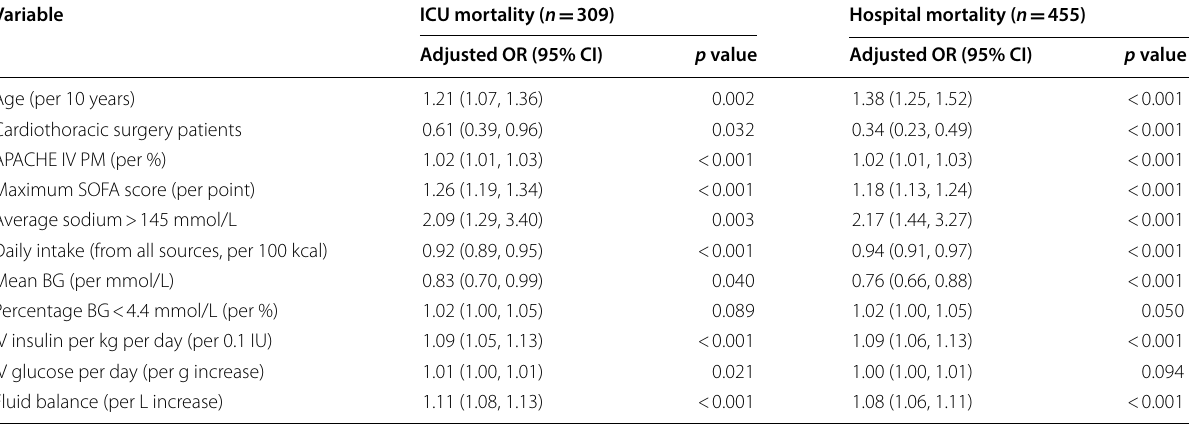
Table 3 Multivariate logistic regression analysis for the association with ICU and hospital mortality in all included patients ( n 3966) =